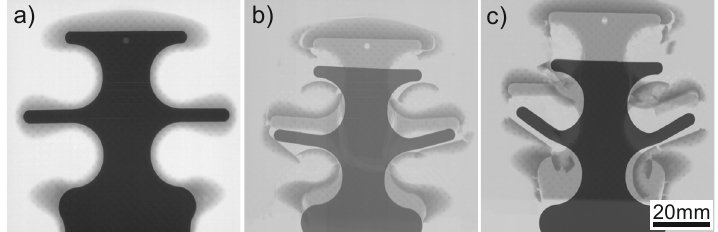
Figure 8. Two-dimensional projections of te hybrid specimens: ( a ) reference, ( b ) tested @23 °C, and ( c ) tested @60 °C (70 kV acceleration voltage, 49 µm pixel size), respectively.